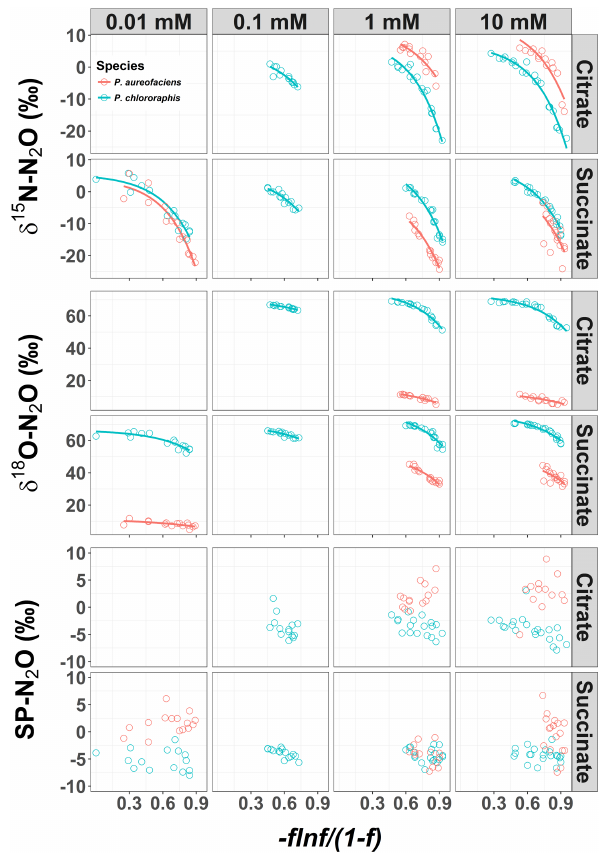
Figure 2. Density distributions (DDs) of δ 15 N net isotope effects Figure 1. δ 15 N, δ 18 O and site preference (SP) of N 2 O produced ( η ) derived from the derivative of the exponential function (Eq. 4) during denitrification of NO − by Pseudomonas chlororaphis subsp. 3 describing the relationship between δ 15 N and [ − f ln f/( 1 − f ) ] aureofaciens and Pseudomonas chlororaphis subsp. chlororaphis for Pseudomonas aureofaciens (orange) and Pseudomonas chloro- with different electron donor sources and concentrations. A larger raphis (blue). Estimates of η were produced over the entire extent value of [ − f ln f/( 1 − f )], where f is the fraction of substrate re- of the reaction (i.e. f = 0 to 1). The left panel displays the DDs for maining, represents earlier points in the reaction. The curved rela- citrate treatments and the right panel displays the DDs for succinate tionships are of the form y = a + e b [ x ] , where y is the isotope value, treatments. Positive values of η were not observed during reactions. x is [ − f ln f/( 1 − f )] and a and b are the estimated coefficients that Tally marks at the base of each panel indicate the actual distribution affect the y intercept and curvilinear shape, respectively. of calculated